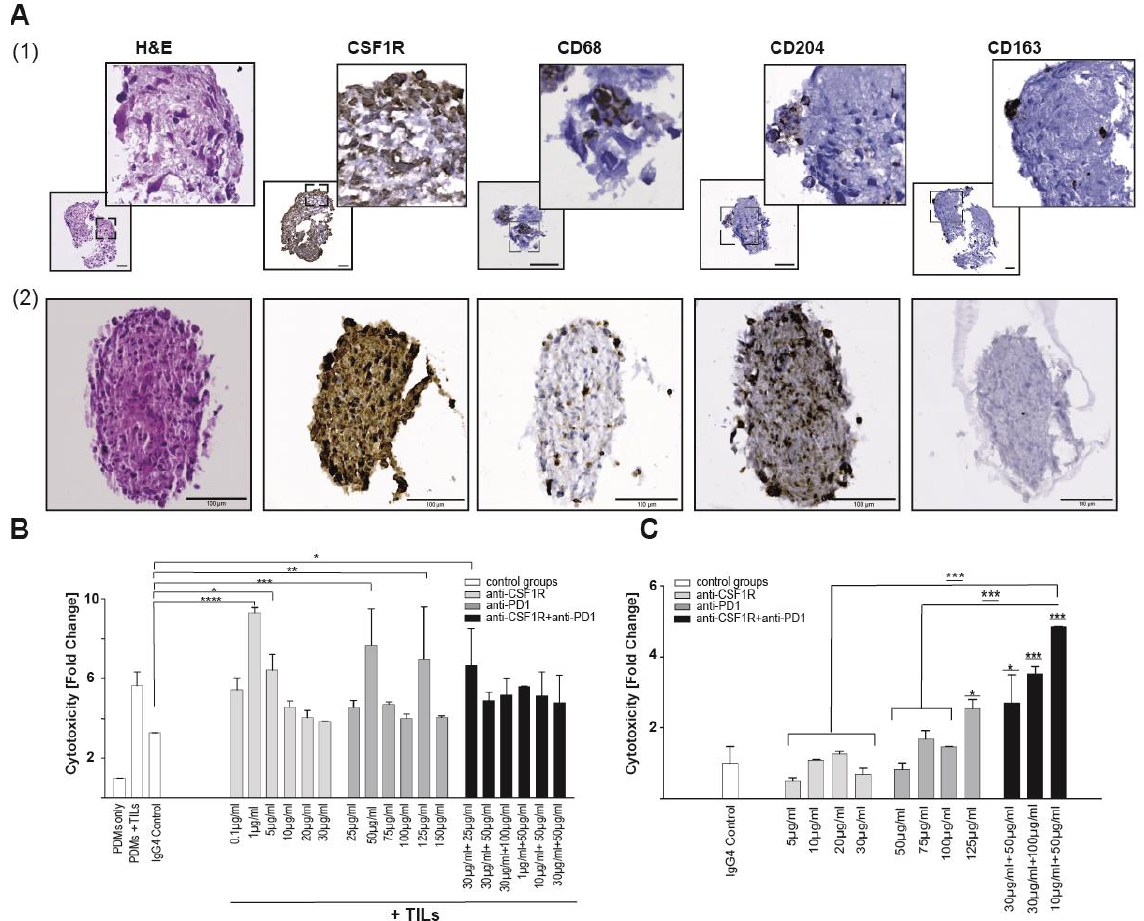
Figure 7. Treatment-induced cytotoxicity in PDMs and PDM/TILs coculture. ( A ) Immunohistochemistry staining of ( 1 ) PDM model 1 and ( 2 ) PDM model 2 for markers of macrophages (CD68), tumor-associated macrophages markers (CD204 and CD163), and CSF1R. Scale bars 100 µm. ( B ) PDM model 1, coculture with autologous TILs, treatments and concentrations as indicated after 72 h ( n = 3 per concentration). Fold changes were normalized to PDMs only. Two-way ANOVA followed by Dunnett’s multiple comparison test was used. PDMs+IgG4-Control served as control group. **** p < 0.0001, *** p < 0.001, ** p < 0.01, * p < 0.05. ( C ): PDM model 2 was treated in the absence of TILs with either CSF1R/ PD1 or combination treatments and concentrations as indicated. Cytotoxicity was measured after 72 h. Fold changes were normalized to isotype control; significance above bars refer to control group. Two-way ANOVA followed by Dunnett’s multiple comparison test was used. PDMs +IgG4-Control served as control group. *** p < 0.001, * p < 0.05.